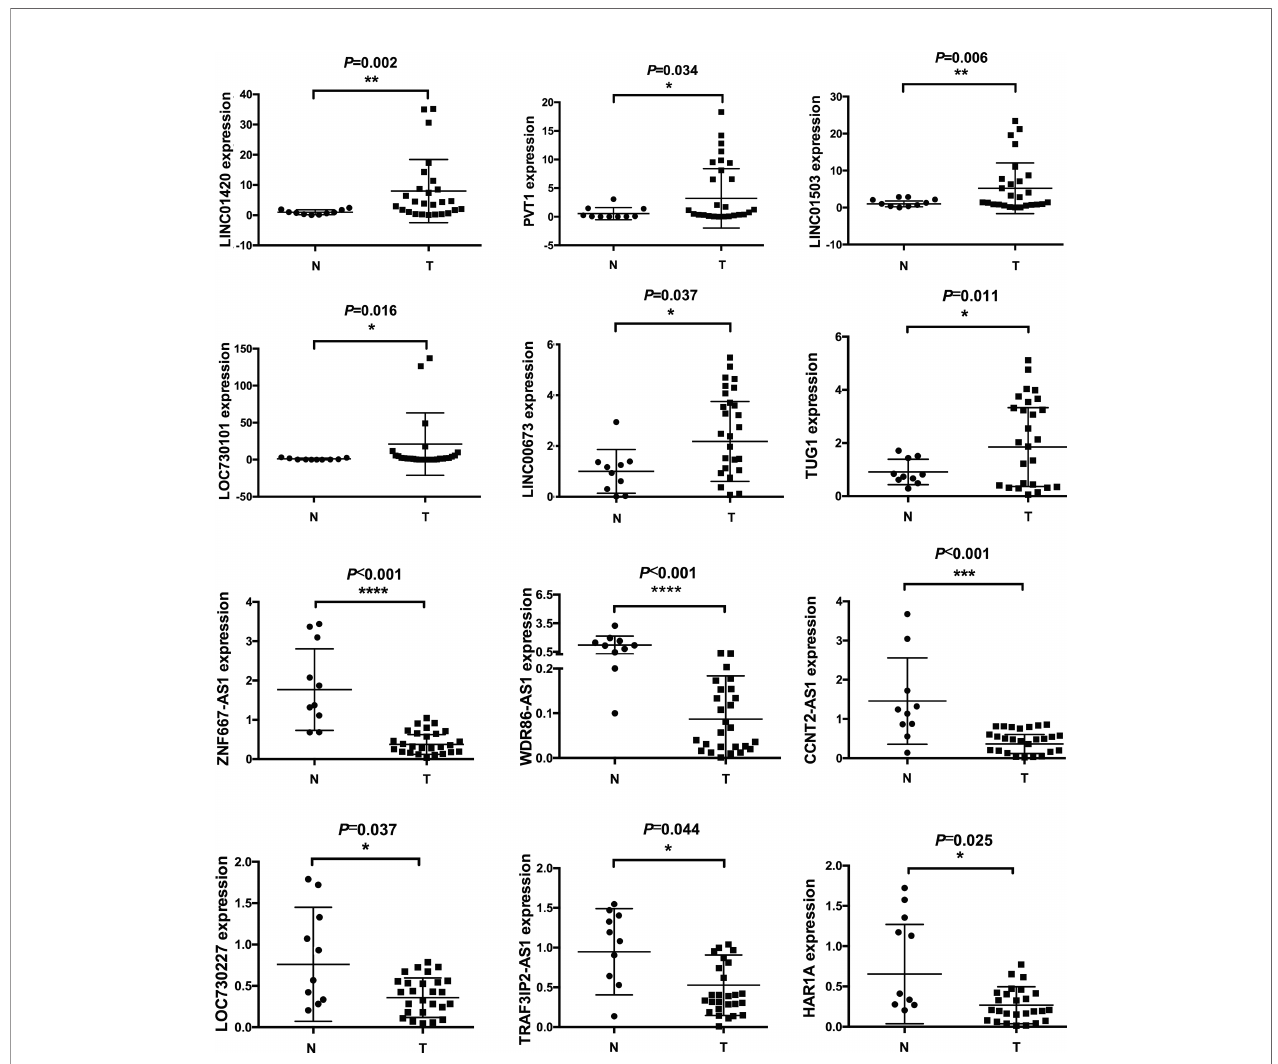
FIGURE 2 | Differentially expressed lncRNAs were validated by qPCR. 10 normal and 26 cancerous tissues were used to detect expression levels of lncRNAs. Six upregulated and six downregulated lncRNAs were validated. * means p<05, ** means p<0.01, *** means p<0.001, **** means